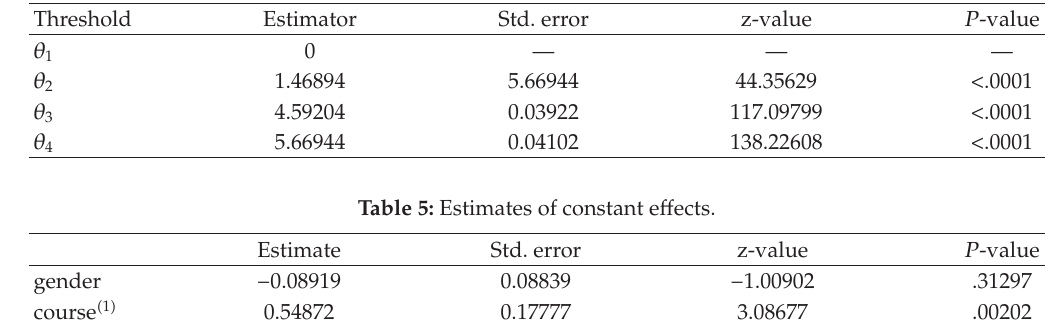
Table 4: Estimates of threshold parameters.